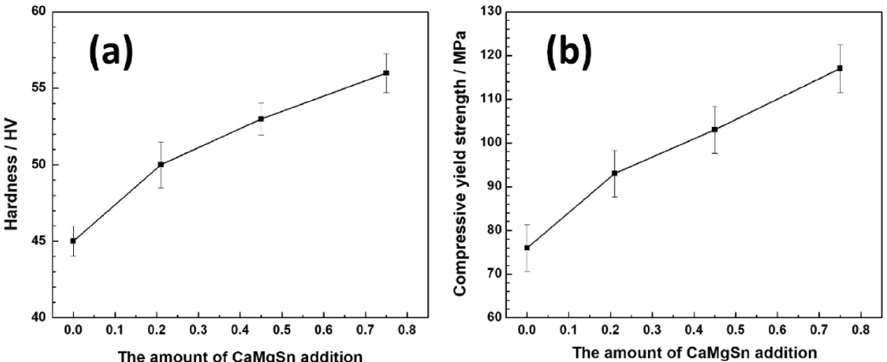
Figure 8. Microhardness ( a ) and compressive yield strength ( b ) of AZ31 with different amounts of CaMgSn addition.